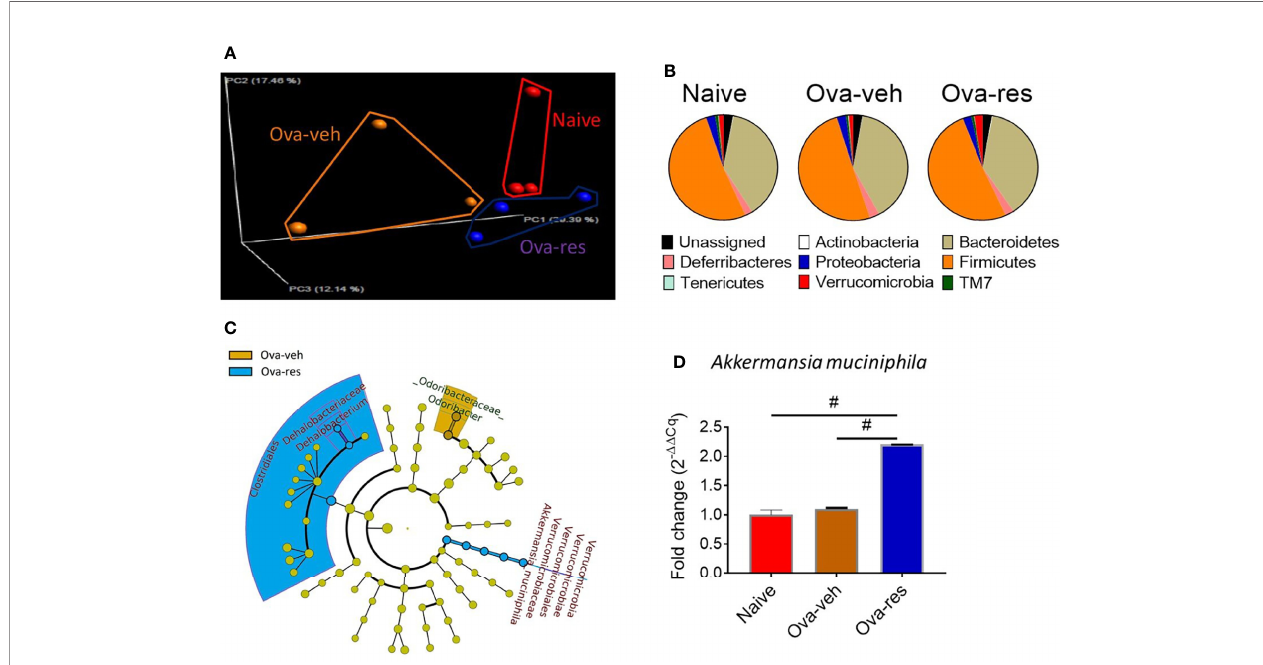
FIGURE 2 | Effect of resveratrol on lung microbiota. OVA and RES treatments were performed as described in Figure 1 legend. The lung microbiota pro fi le was conducted as described in Methods. (A) Principal coordinator analysis showing the speci fi c distribution of lung microbiota in naïve, Ova-veh and Ova-res groups. (B) Pie charts showing the percentages of common bacterial phyla in the lung microbiota among naïve, Ova-veh and Ova-res groups. (C) cladogram showing the least signi fi cant discriminative changes of lung microbiota between Ova-veh and Ova-res group with at least 2-fold changes. (D) qPCR showing the abundance of Akkermansia muciniphila in mouse lung microbiota among naïve, Ova-veh and Ova-res groups. Vertical bars in panel D represent Mean+/-SEM data from groups of 5 mice. In panel (A) , 2 mice out of 5 were excluded by Nephele setting). #